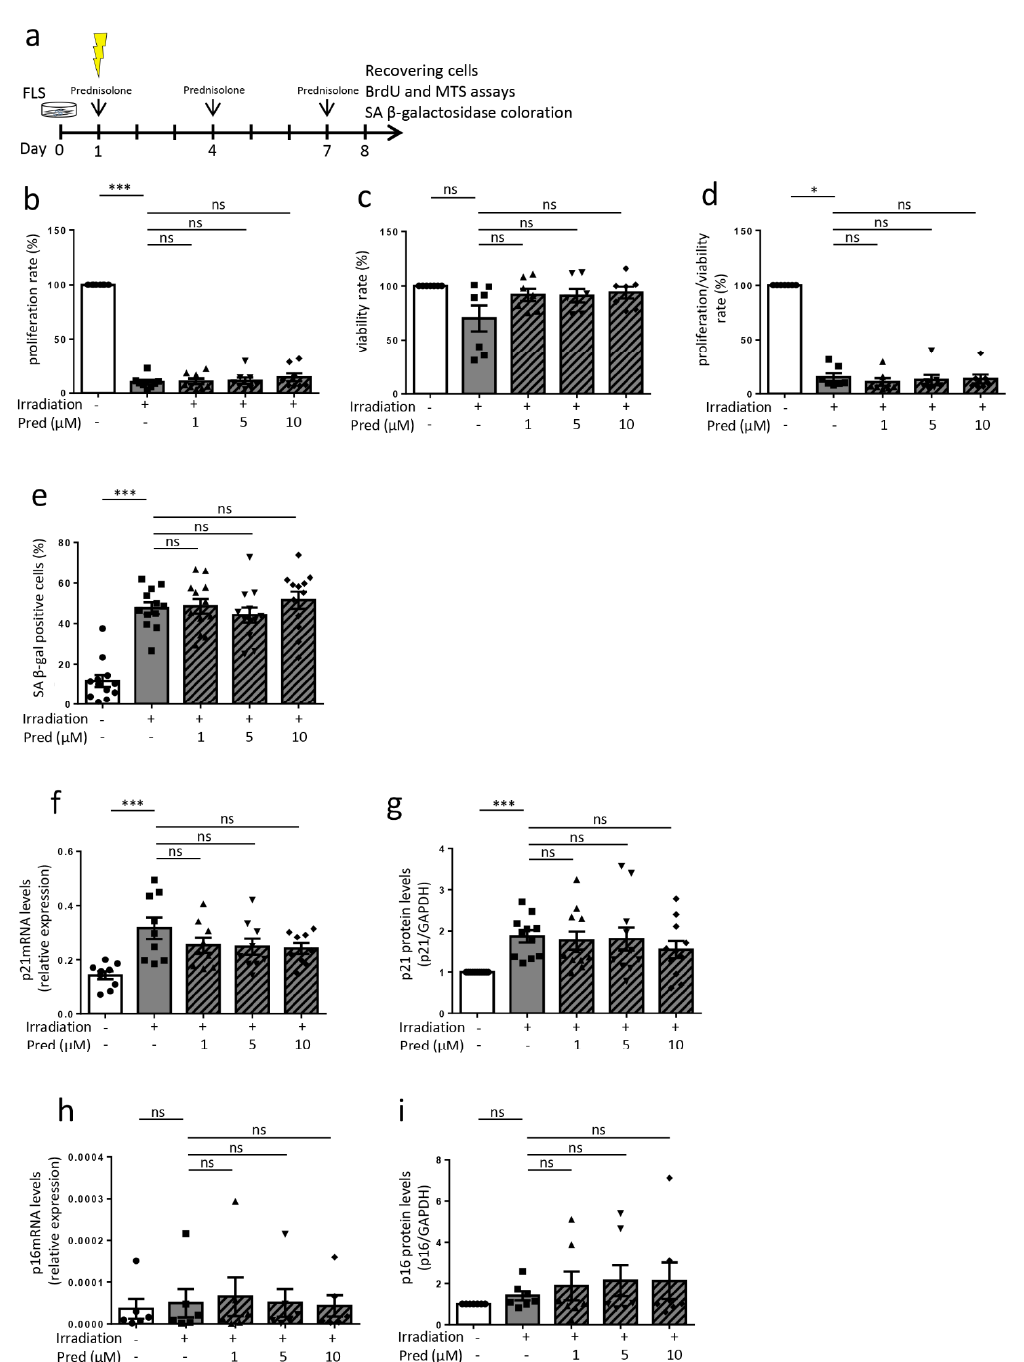
Figure 3. Effect of prednisolone on senescence induction in osteoarthritic fibroblast-like synoviocytes at day 8. ( a ) Experimental design. ( b ) Proliferation rate analysis (BrdU incorporation) ( n = 8). ( c ) Viability rate analysis (MTS analysis) ( n = 7). ( d ) Proliferation/viability ratio ( n = 7). ( e ) β -galactosidase staining ( n = 12). ( f , g ) p21 mRNA expression by RT-qPCR (data expressed as 2ˆ − ∆ Ct, n = 9) and protein expression by Western blotting (levels reported on GAPDH expression, n = 11). ( h , i ) p16 INK4A mRNA expression by RT-qPCR (data expressed as 2ˆ − ∆ Ct, n = 6) and protein expression by Western blotting (levels reported on GAPDH expression, n = 7). Results are expressed as mean ± SEM; * p < 0.05, *** p < 0.001, ns = not